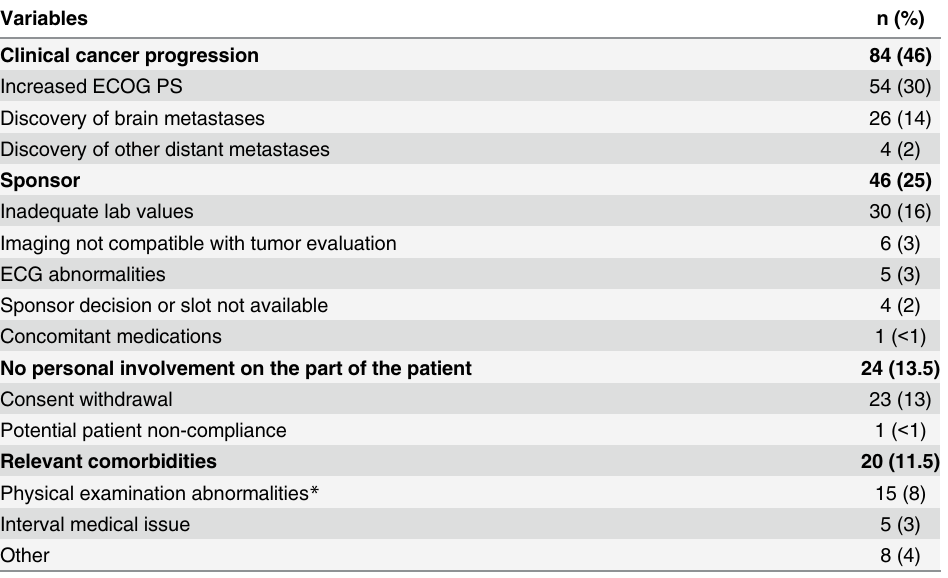
Table 3. Reasons for screen failures in matched